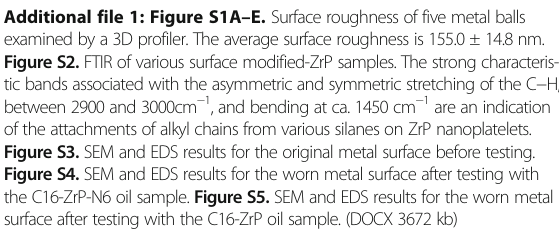
Additional file 1: Figure S1A – E. Surface roughness of five metal balls examined by a 3D profiler. The average surface roughness is 155.0 ± 14.8 nm. Figure S2. FTIR of various surface modified-ZrP samples. The strong characteris- tic bands associated with the asymmetric and symmetric stretching of the C − H, between 2900 and 3000cm − 1 , and bending at ca. 1450 cm − 1 are an indication of the attachments of alkyl chains from various silanes on ZrP nanoplatelets. Figure S3. SEM and EDS results for the original metal surface before testing. Figure S4. SEM and EDS results for the worn metal surface after testing with the C16-ZrP-N6 oil sample. Figure S5. SEM and EDS results for the worn metal surface after testing with the C16-ZrP oil sample. (DOCX 3672 kb)